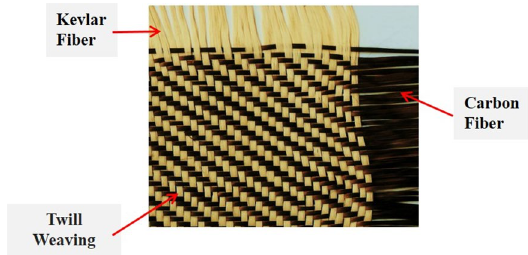
Figure 1. CKS-220 Carbon/Kevlar Hybrid